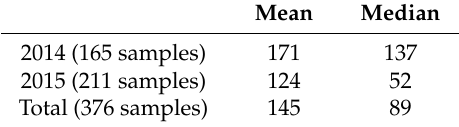
Table 1. Means and medians of the concentration of ethyl carbamate ( µ g/L) in samples of cachaça analyzed during the years 2014 and 2015. Mean Median 2014 (165 samples) 171 137 2015 (211 samples) 124 52 Total (376 samples) 145 89 Mean = arithmetic mean; median = 50th percentile.